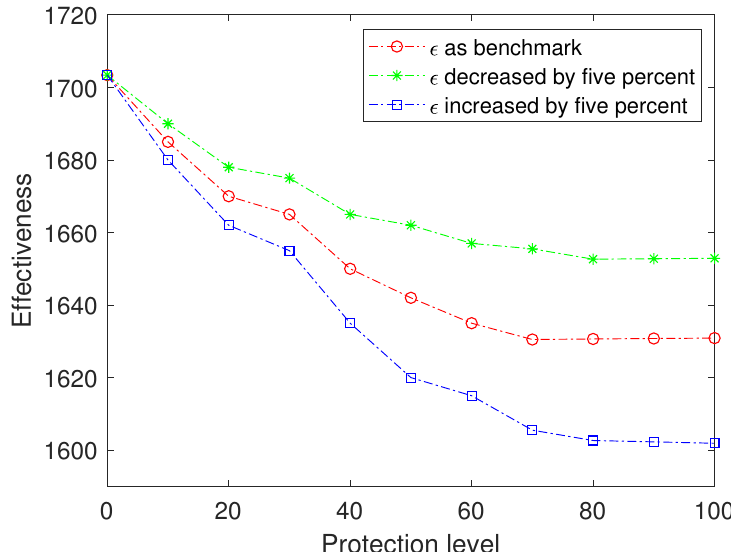
Figure 5. Effectiveness vs. disturbance ratio of